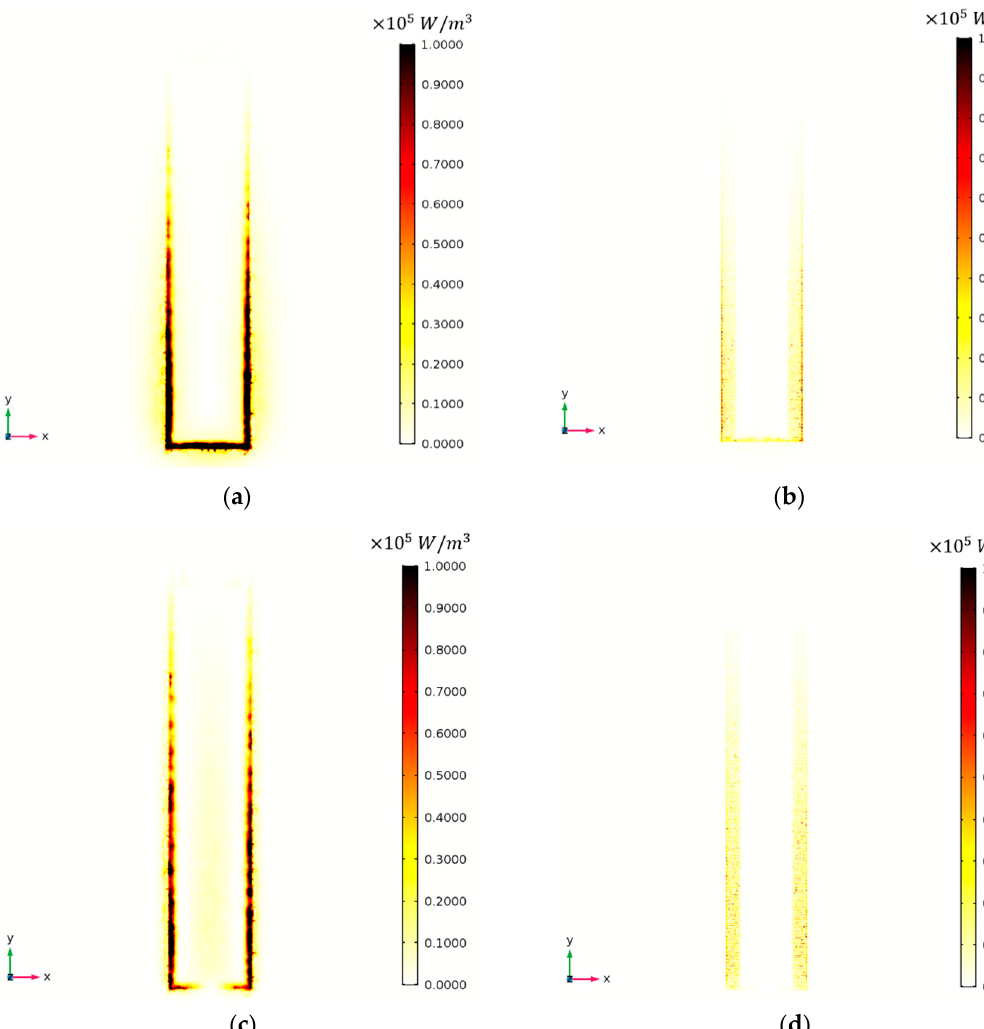
Figure 13. Top view of viscous dissipation density (W/m 3 ). ( a ) Viscous dissipation density around the